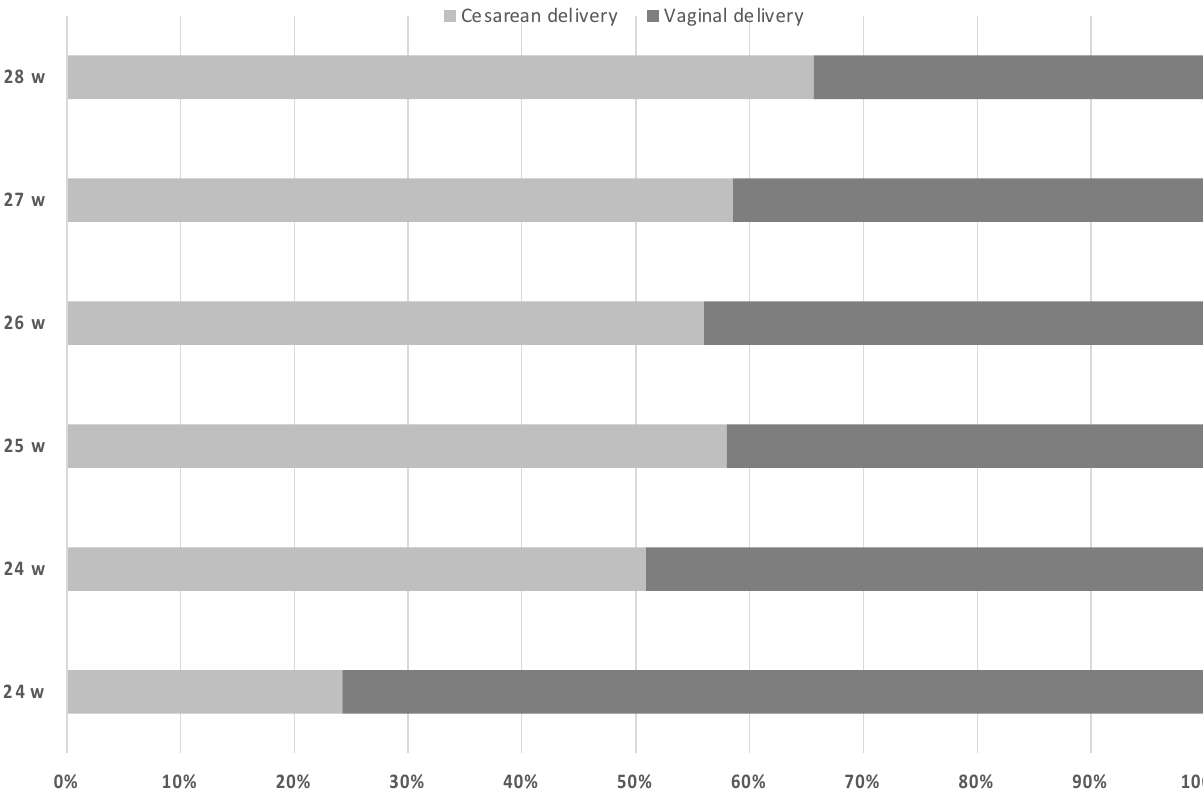
Figure 3. Type of delivery according to gestational age at delivery.